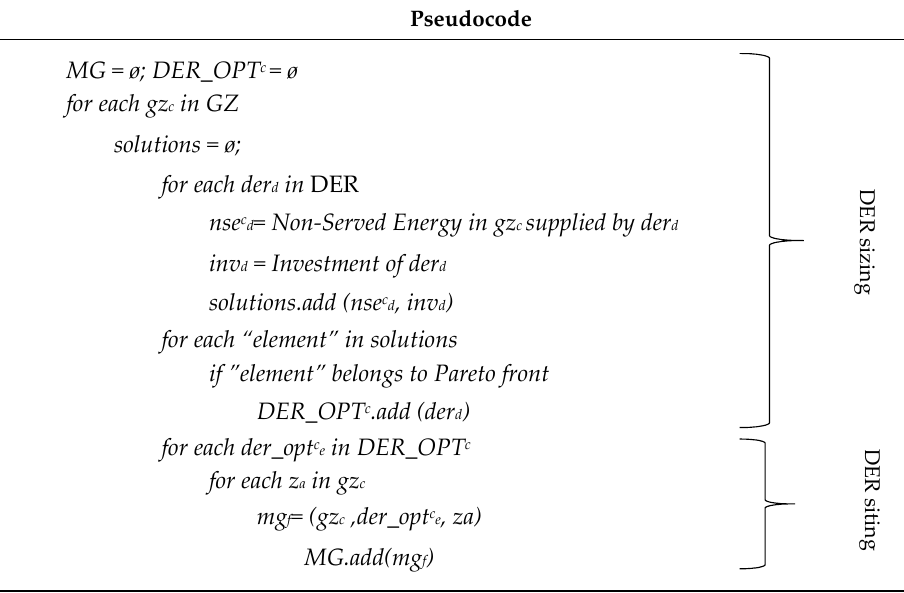
Table 2. Pseudocode for the Micro-Grids MG formation.